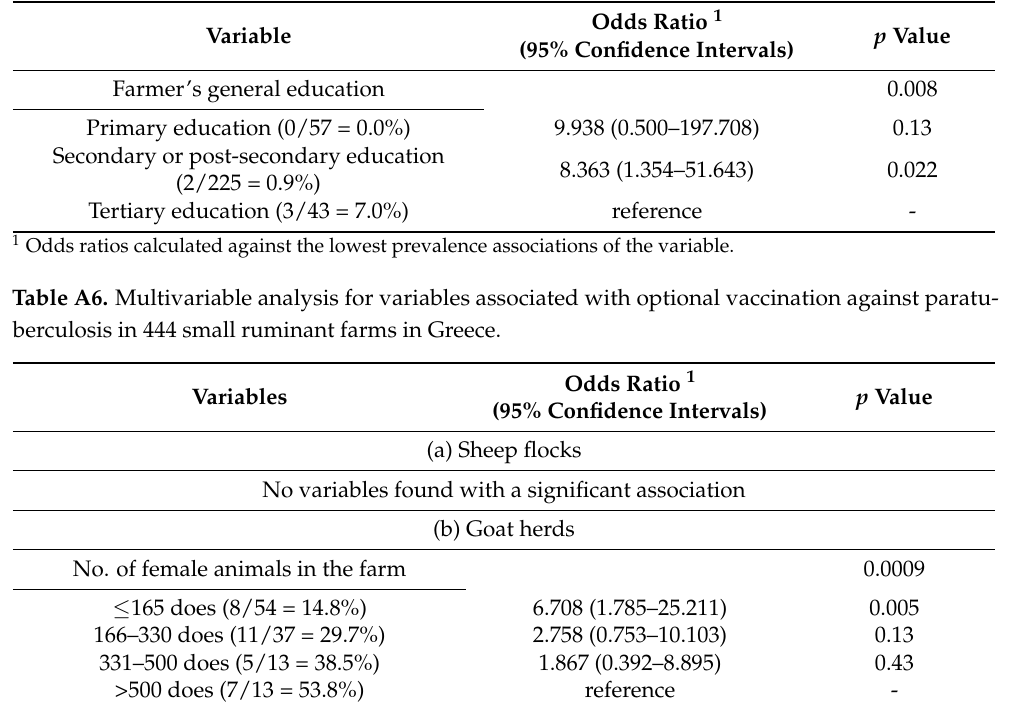
Table A5. Multivariable analysis for variables associated with optional vaccination against foot-rot in 325 sheep farms in Greece.